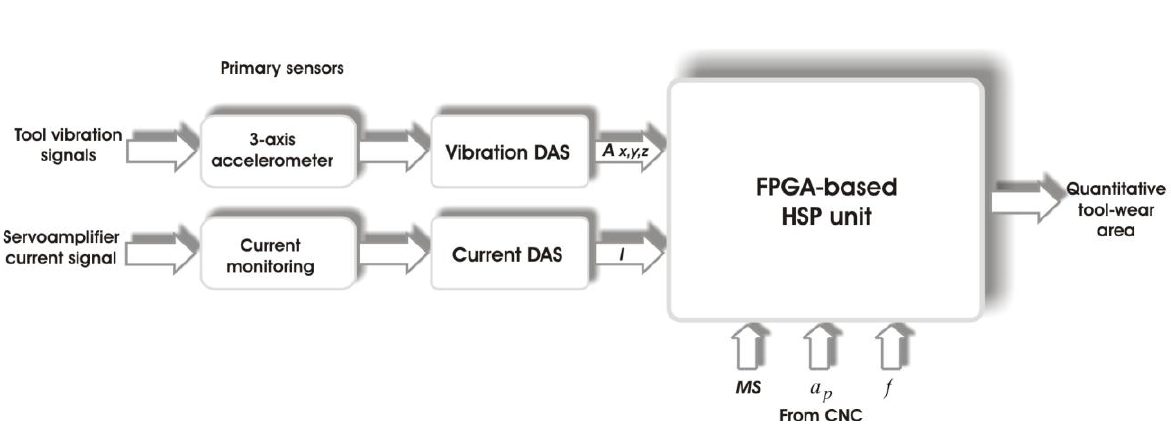
Figure 2. Block diagram of the proposed